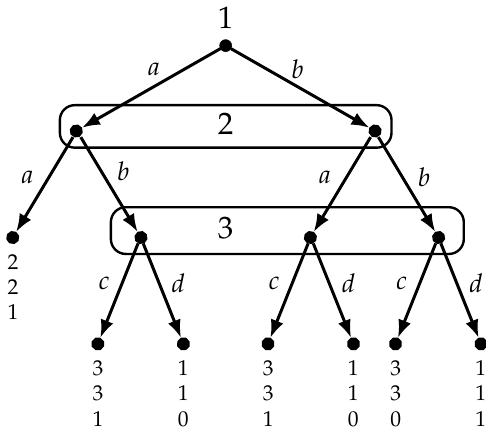
Figure 1. An extensive game with imperfect